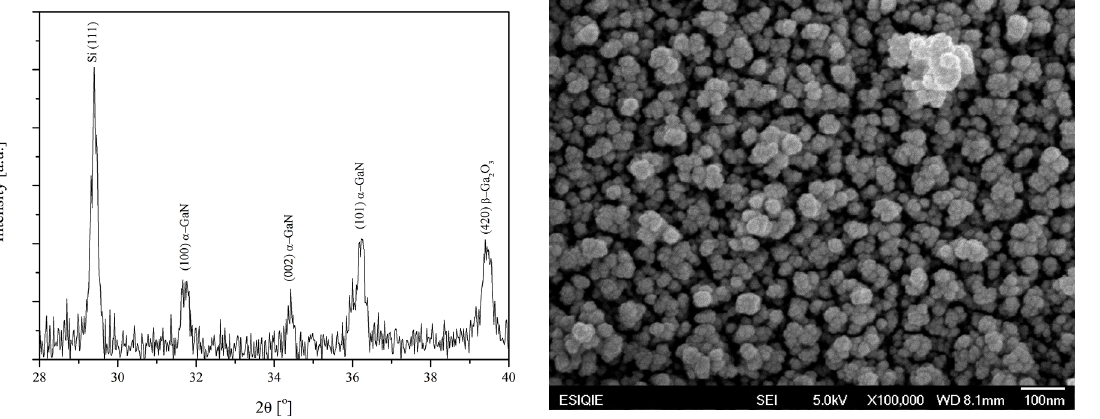
Figure 1. XRD pattern of the GaN film grown on (111) Si substrate. Figure 2. SEM image of GaN film grown on Si (111)